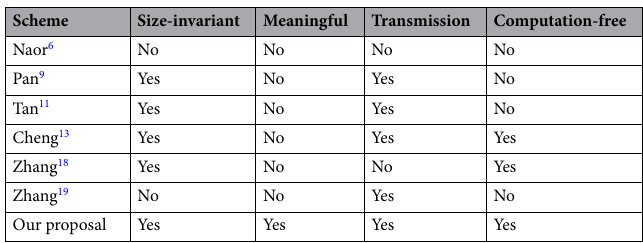
Table 2. Feature comparisons among our proposal and previous